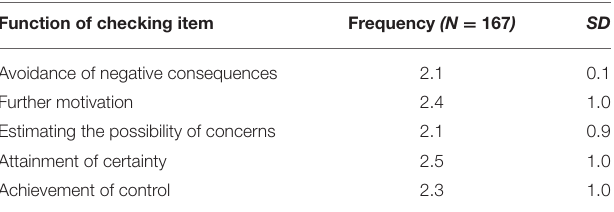
TABLE 4 | Means ( M ) and standard ( SD ) Deviations of Functions of Body Checking. Function of checking